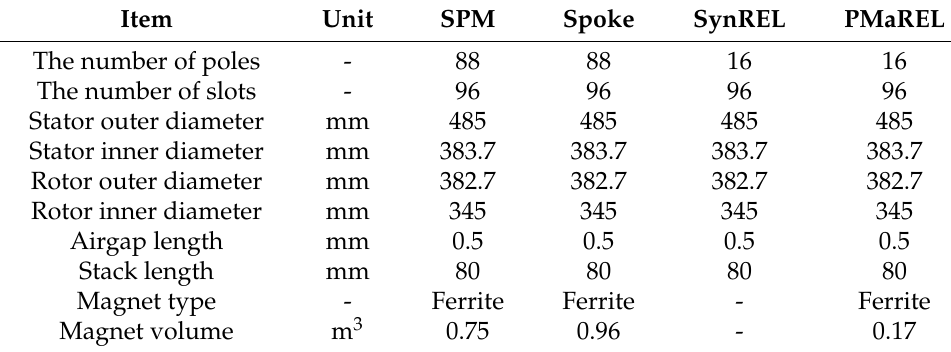
Figure 5. PMaREL motor with Ferrite PMs (PMaREL). Table 2. Specification of